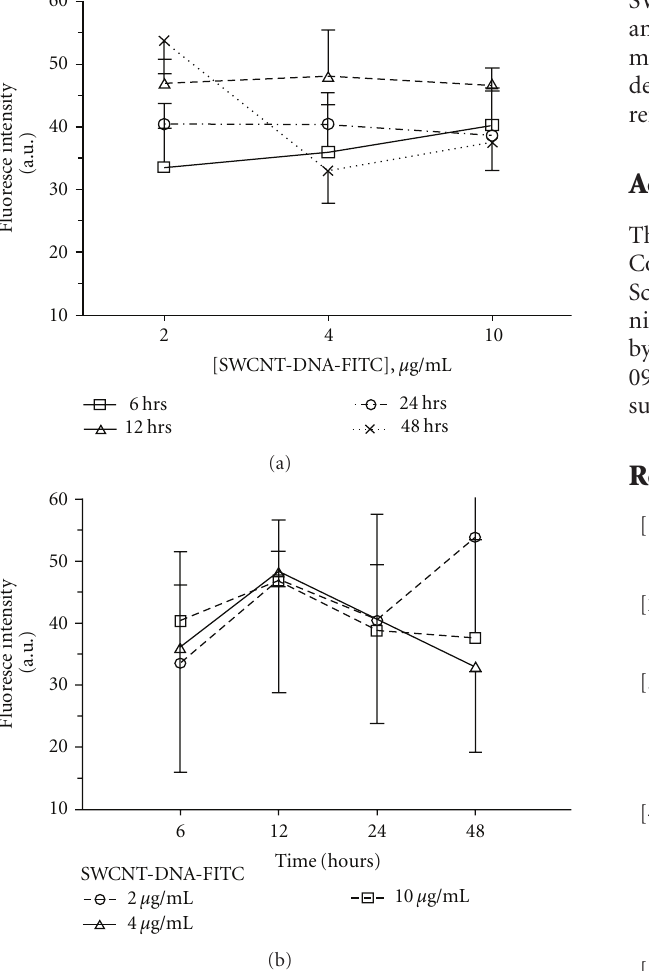
Figure 4: Quantity of SWCNT-DNA-FITC conjugates retained in EC nuclei is concentration- and time-independent. (a) Relationship between quantity of SWCNTDNA-FITC in the nuclei and the concentrations of SWCNT-DNA-FITC conjugates; (b ) Time-course of fluorescence intensity of SWCNT-DNA-FITC in the nuclei of microvascular